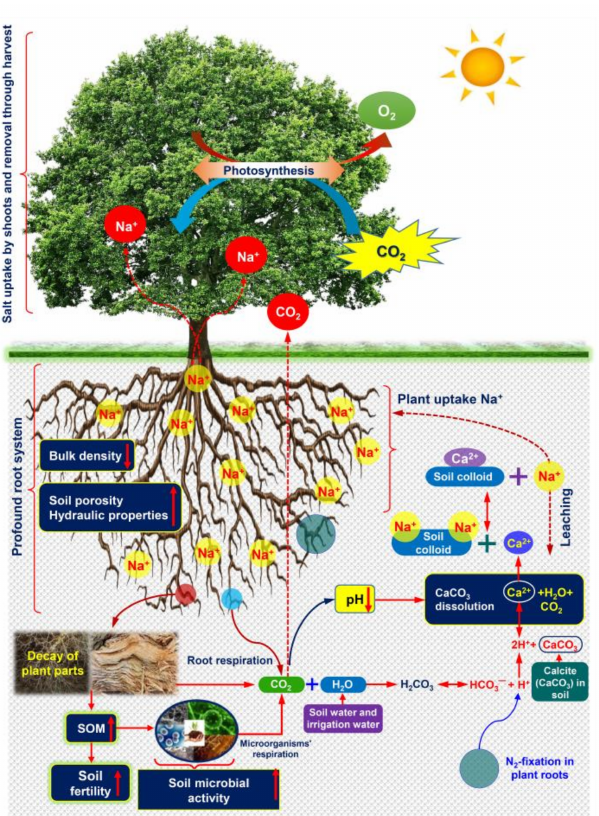
Figure 4. Putative phytoremediation process by halophyte plants in salinity-affected areas, and their beneficial effects on soil properties (modified from Qadir et al. [140] and Jesus et al. [126].